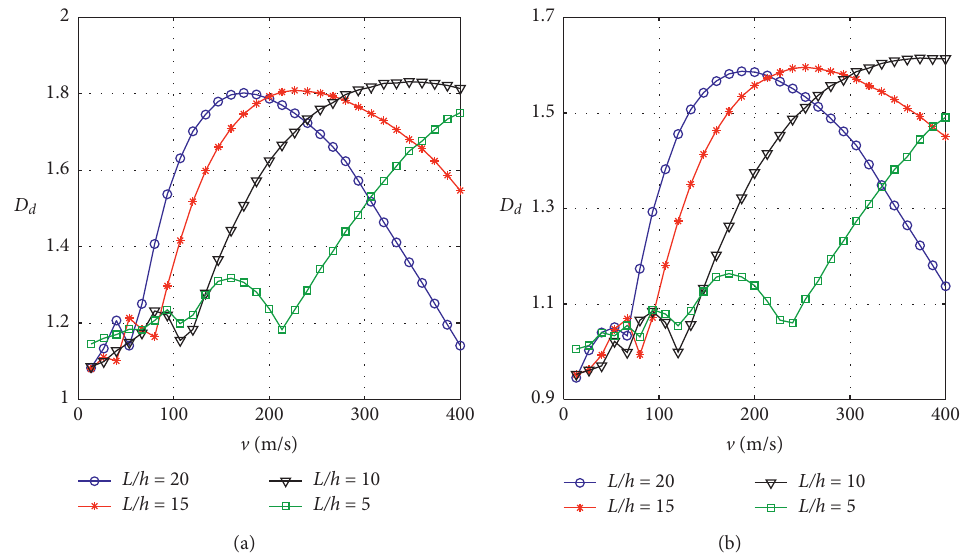
Figure 9: Variation of DMF with moving load speed for n